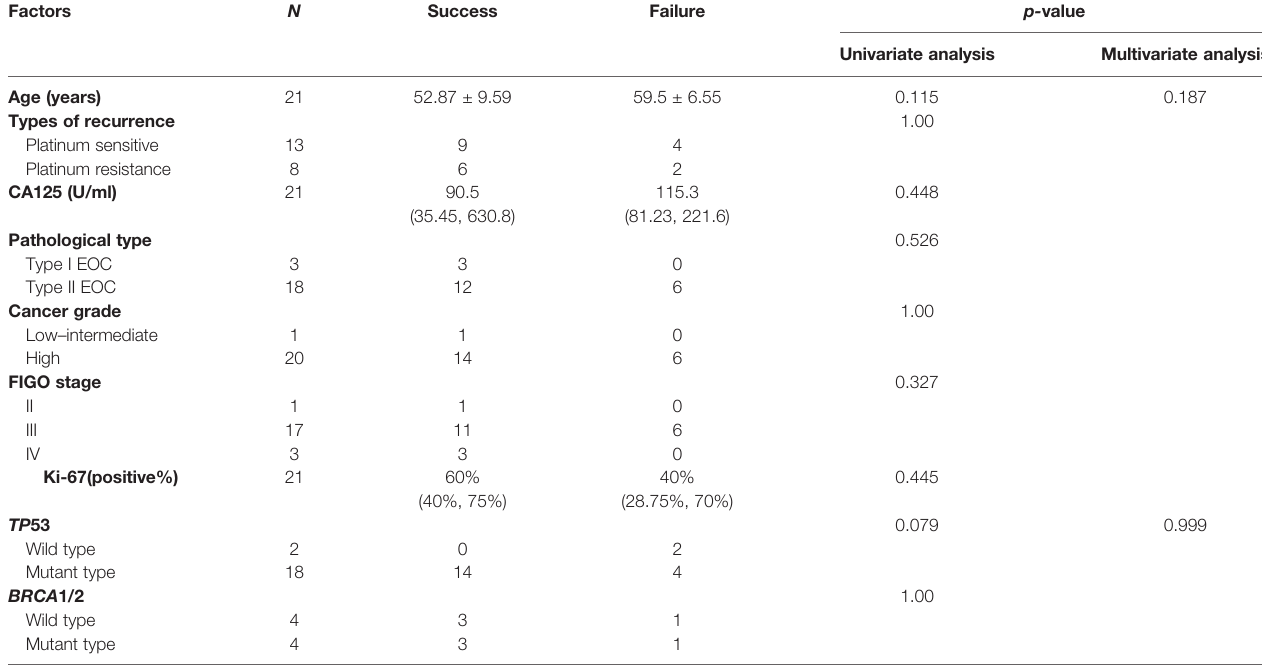
TABLE 2 | Factors affecting engraftment rates in recurrent EOC-PDX models.